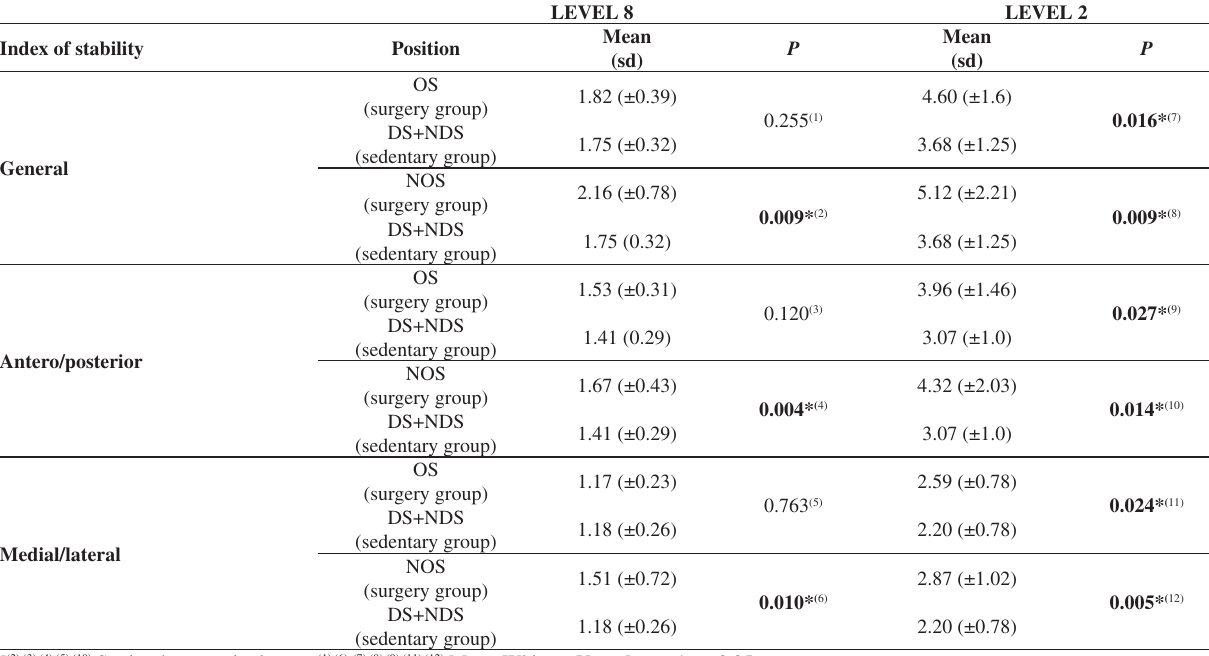
Table 3 - Intergroup comparison of the center of gravity dislocation and postural balance in the Surgery Group (OS and NOS) versus the Sedentary Group (DS and NDS) at stability levels 8 and